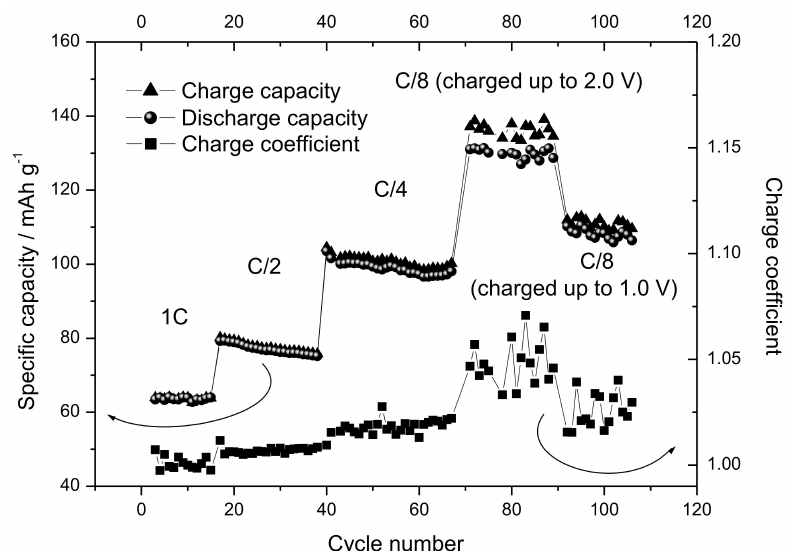
Figure 10. Specific capacity in charge (triangles) and discharge (circles) for the Sn-RGO-based electrode recorded at various charge rates as a function of the cycle number. The charge rates are reported in the figure. The squares indicate the charge